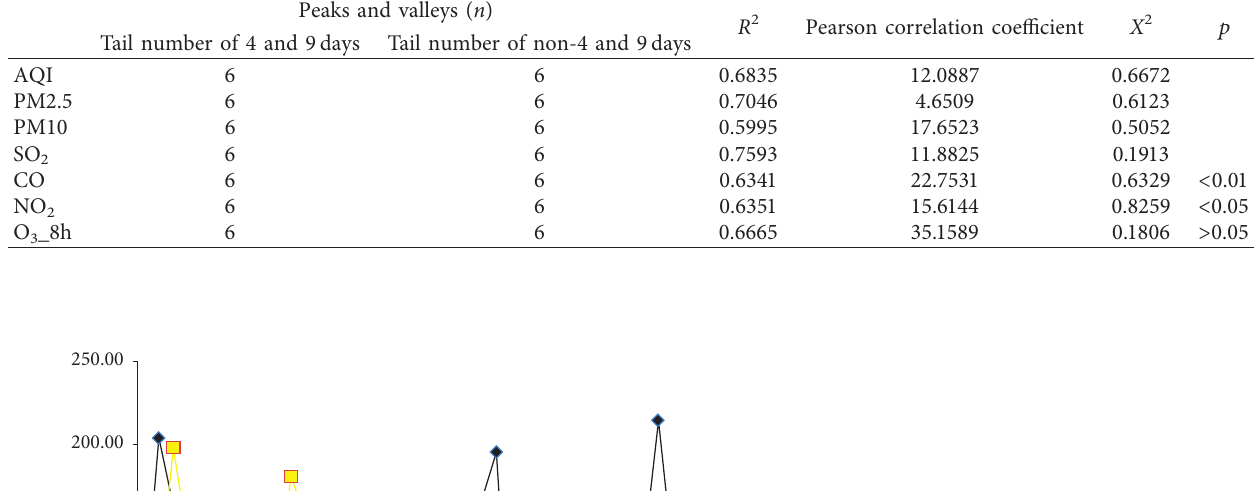
Table 2: Pearson correlation analysis of restricted days with non-4 and 9 restricted days. Peaks and valleys ( n